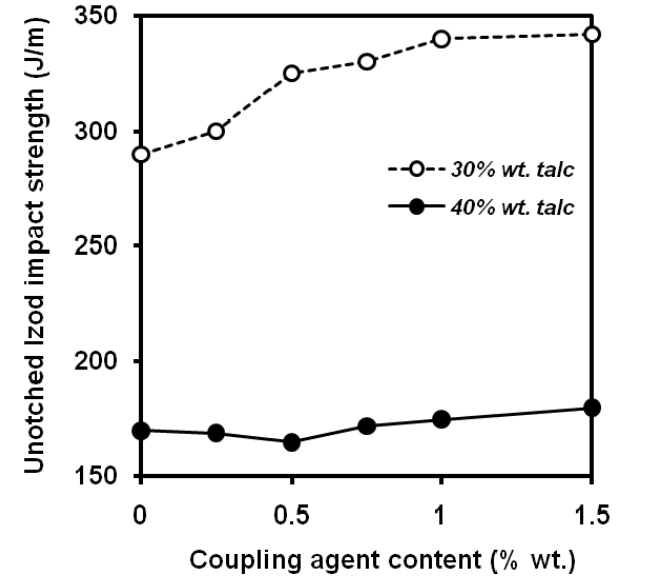
of PP-based composites with c